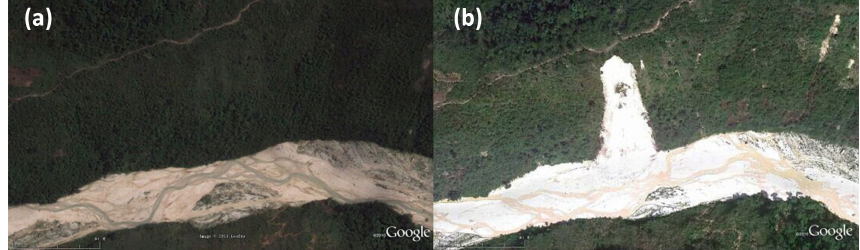
Figure 4. A landslide (18 ◦ 29 0 16.89 00 N, 72 ◦ 24 0 37.53 00 W) occurred after the earthquake but may have been triggered by rainfall. (a) was taken on 18 August 2010 and (b) was taken on 9 November 2010 (upward is